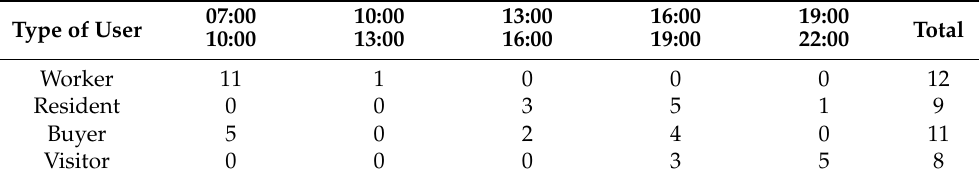
Table 6. Type of users for time